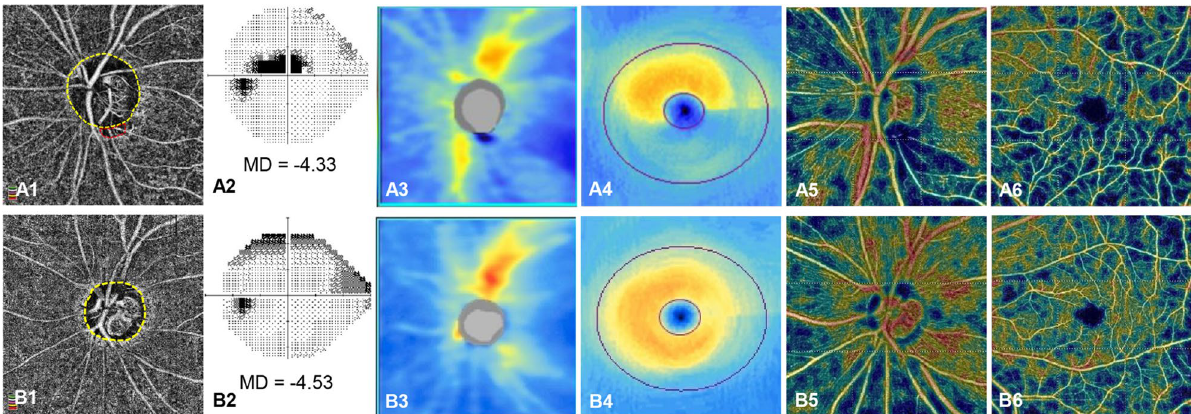
Figure 2. Representative cases ( A,B ) of open-angle glaucoma (OAG) eyes with and without choroidal microvasculature dropout (CMvD) showing different clinical characteristics. In the En face parapapillary choroidal layer image from optical coherence tomography angiography (OCT-A) analysis of OAG eye with CMvD ( A1 ) and that of OAG eye without CMvD ( B1 ), yellow and red dot outlines indicate the optic nerve head and CMvD borders, respectively. The CMvD+ eye showed a central visual field (VF) defect ( A2 ) with a VF mean deviation (MD) of −4.33 decibel (dB), whereas the CMvD− eye showed a peripheral VF defect ( B2 ) with a similar VF MD of −4.53 dB. On the spectral-domain optical coherence tomography (SD-OCT) thickness map, the CMvD+ eye showed localized circumpapillary retinal nerve fibre layer thickness (cpRNFLT) loss at the inferior temporal (IT) sector (50.5 µ m ) and at the temporal (T) sector (58.0 µ m ) , which was adjacent to the site of the CMvD ( A3 ). The CMvD+ eye also revealed macular ganglion cell-inner plexiform layer (mGCIPL) thinning at the inferior hemiretina, including IT sector (57.3 µ m , A4 ). On the color-coded OCT-A map, the circumpapillary vessel density (cpVD) reduction was detected at the IT region (23.7%, A5 ), while a macular vessel density (mVD) reduction (36.4%) was also observed at the inferior hemiretina ( A6 ). The CMvD− case ( B1 ), however, demonstrated a peripheral VF defect ( B2 ) with cpRNFLT loss at the IT sector (61.0 µ m , B3 ), while there was less pronounced mGCIPL thinning at this sector (70.0 µ m , B4 ). On the color-coded OCT-A map, despite the slight cpVD reduction detected at the IT region (39.7%, B5 ) where the cpRNFLT loss was observed, an mVD reduction in the CMvD− eye was not as apparent in the inferior hemiretina ( B6 ) as that in the CMvD+